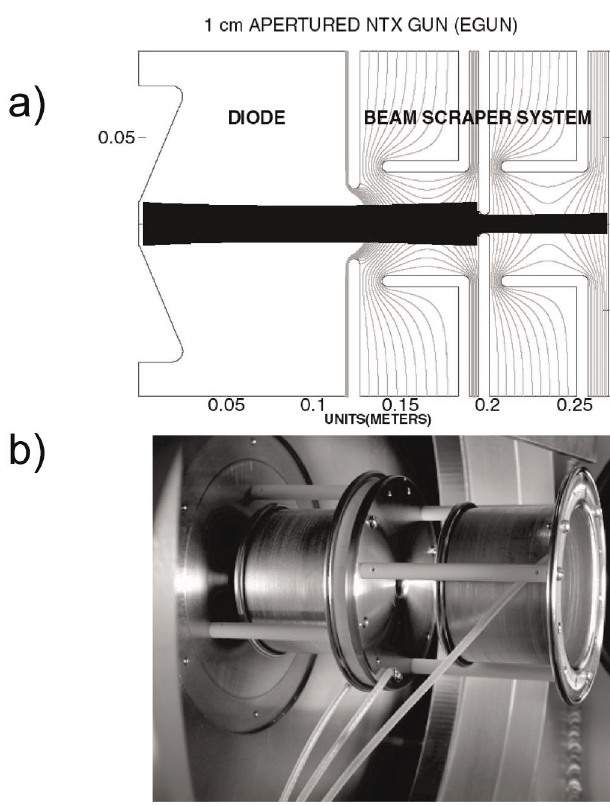
FIG. 4. (a) Equipotential plot of the beam scraper system, and (b) aperture and electron trap system located at the exit of the NTX